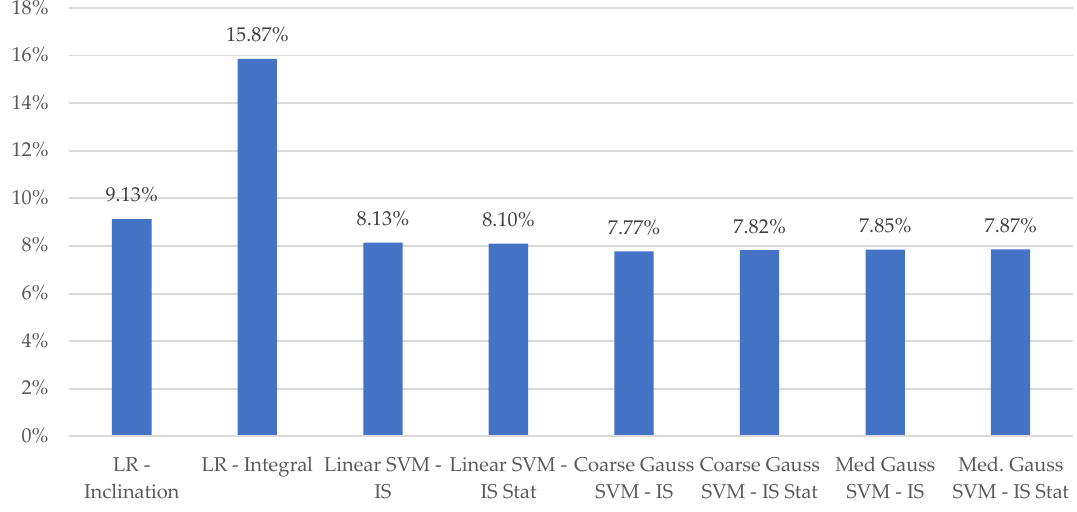
Sensors 2019 , 19 , x FOR PEER REVIEW Figure 10. Variation in the fill ratio mean absolute percentage error for the various models considered.